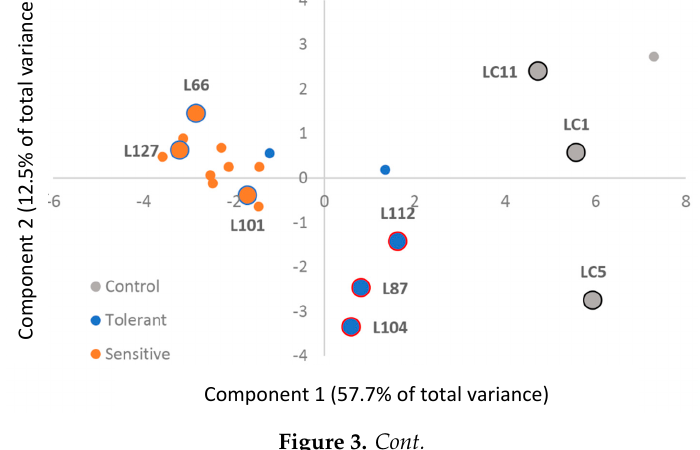
Figure 3. Principal component analysis of the physiological and morphological variables measured. A representation of the variables contributing to each component is included. 3.2. Gene Expression Changes in Response to Salinity The plants chosen for transcriptomic sequencing were selected with the confirmation of the tolerance by the physiological responses after the saline stress (Figure 3). To visualize the gene expression profiling results, a principal component analysis (PCA) was conducted using the transcriptomic data for all samples. In this analysis, a clear separation was observed between roots and leaves. Leaves showed little variability between the three categories (Figure 4). However, the percentage of variability explained between control and treated roots was of the same order of magnitude as that between leaves and roots. Furthermore, the separation between tolerant and sensitive plants was also significant based on root transcriptomic data as shown in Figure 4. This separation was consistent with the phenotypic data presented above.